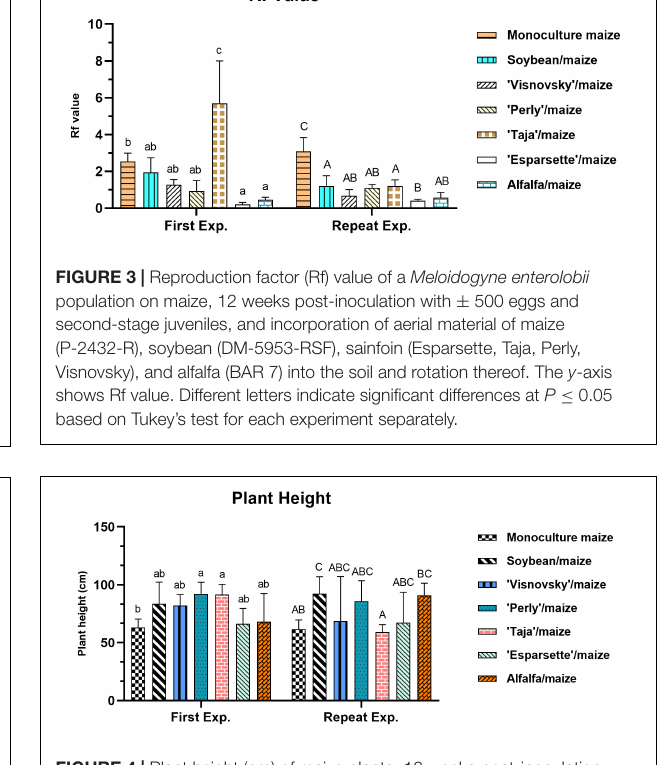
FIGURE 2 | Variable Meloidogyne enterolobii density levels in roots of maize 12 weeks post-inoculation with ± 500 eggs and second-stage juveniles, and reduction in nematode population.